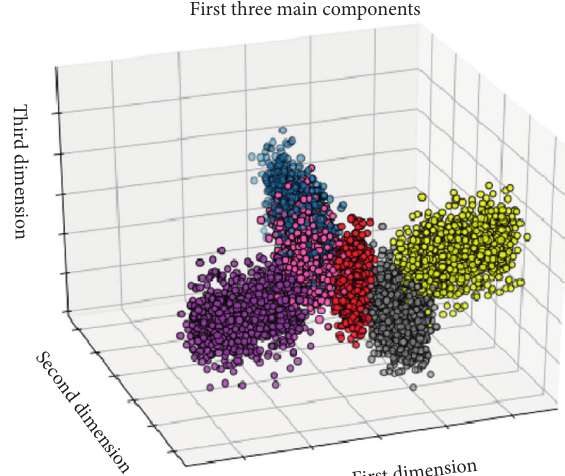
Figure 6: 3D scatter plot of data after PCA